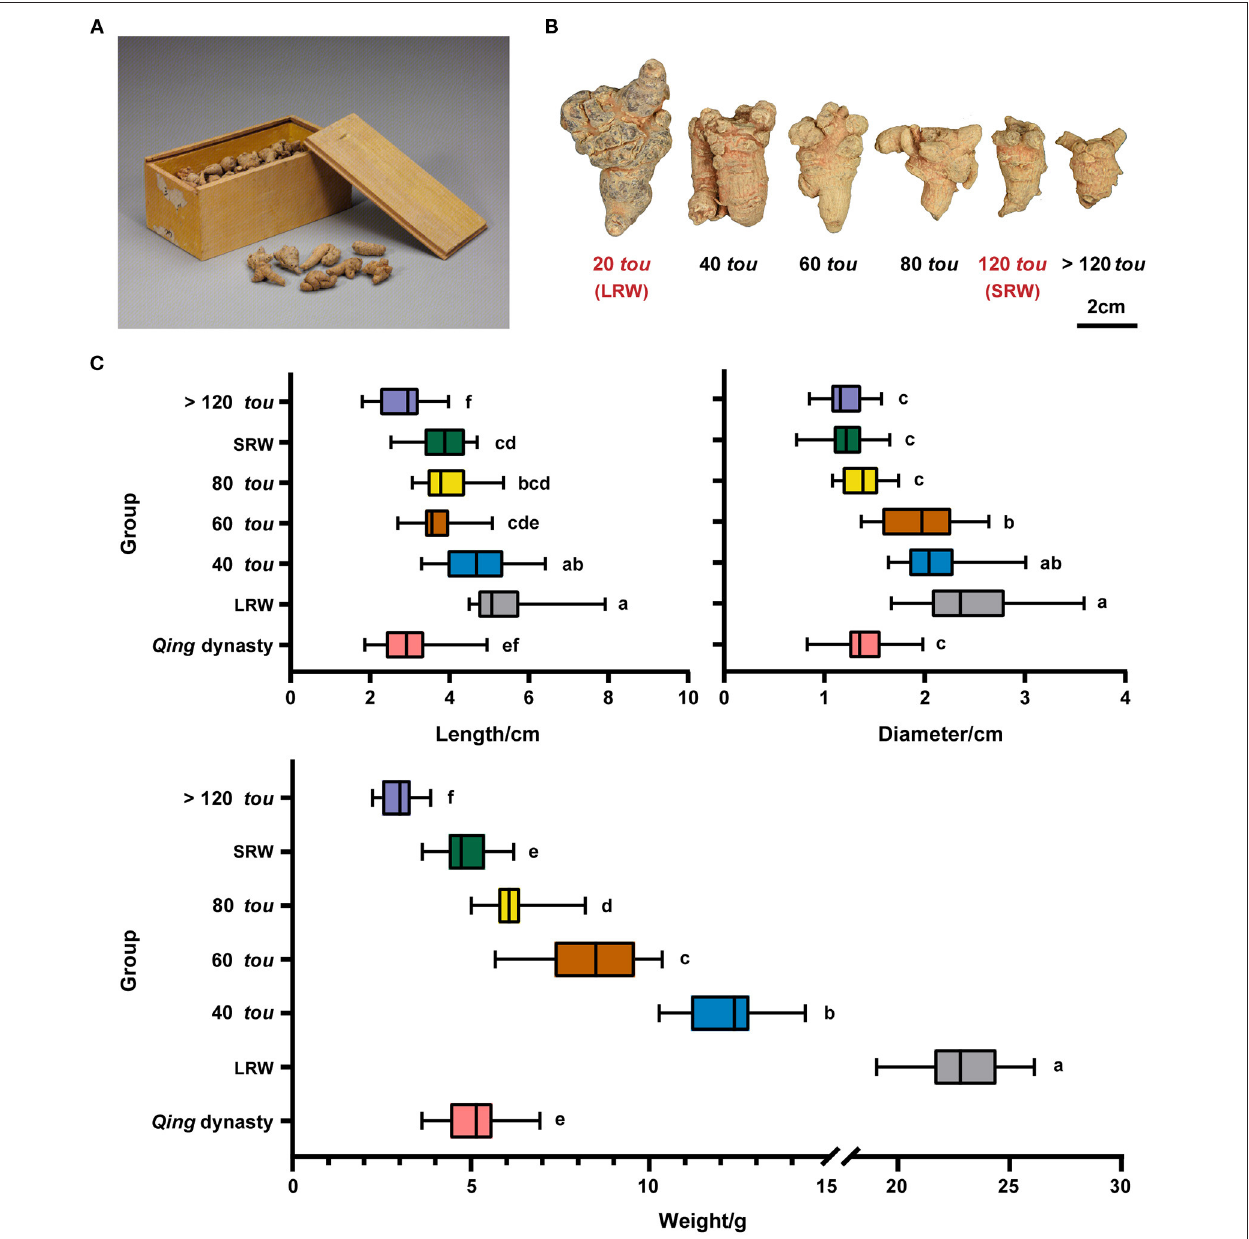
FIGURE 1 | Morphological features of P. notoginseng in Qing dynasty and modern times. (A) P. notoginseng in Qing dynasty, relic number, Gu00172482-8/9. (B) P. notoginseng of different root sizes (20 tou , 40 tou , 60 tou , 80 tou , 120 tou, and > 120 tou ; tou is the number of roots per 500g). (C) Length, diameter, and weight of P. notoginseng in Qing dynasty ( n = 30) and in modern times ( n = 20). Data are shown in box plot, and the different letters indicate values that vary significantly at P < 0.05 (one-way